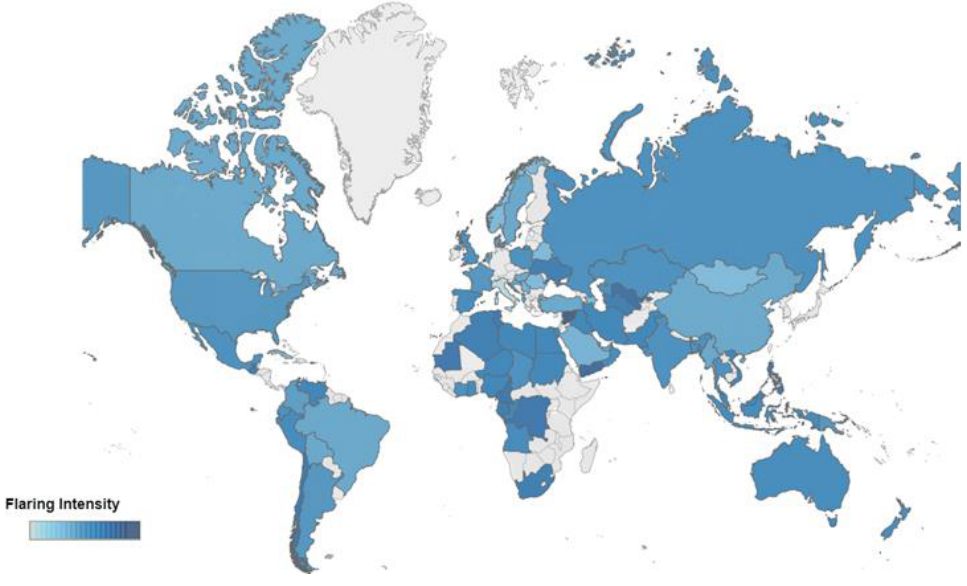
Figure 1. Flaring intensity (m 3 /barrel). Source: